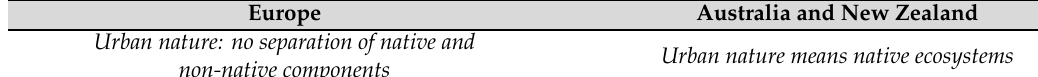
Table 2. Vision of Two